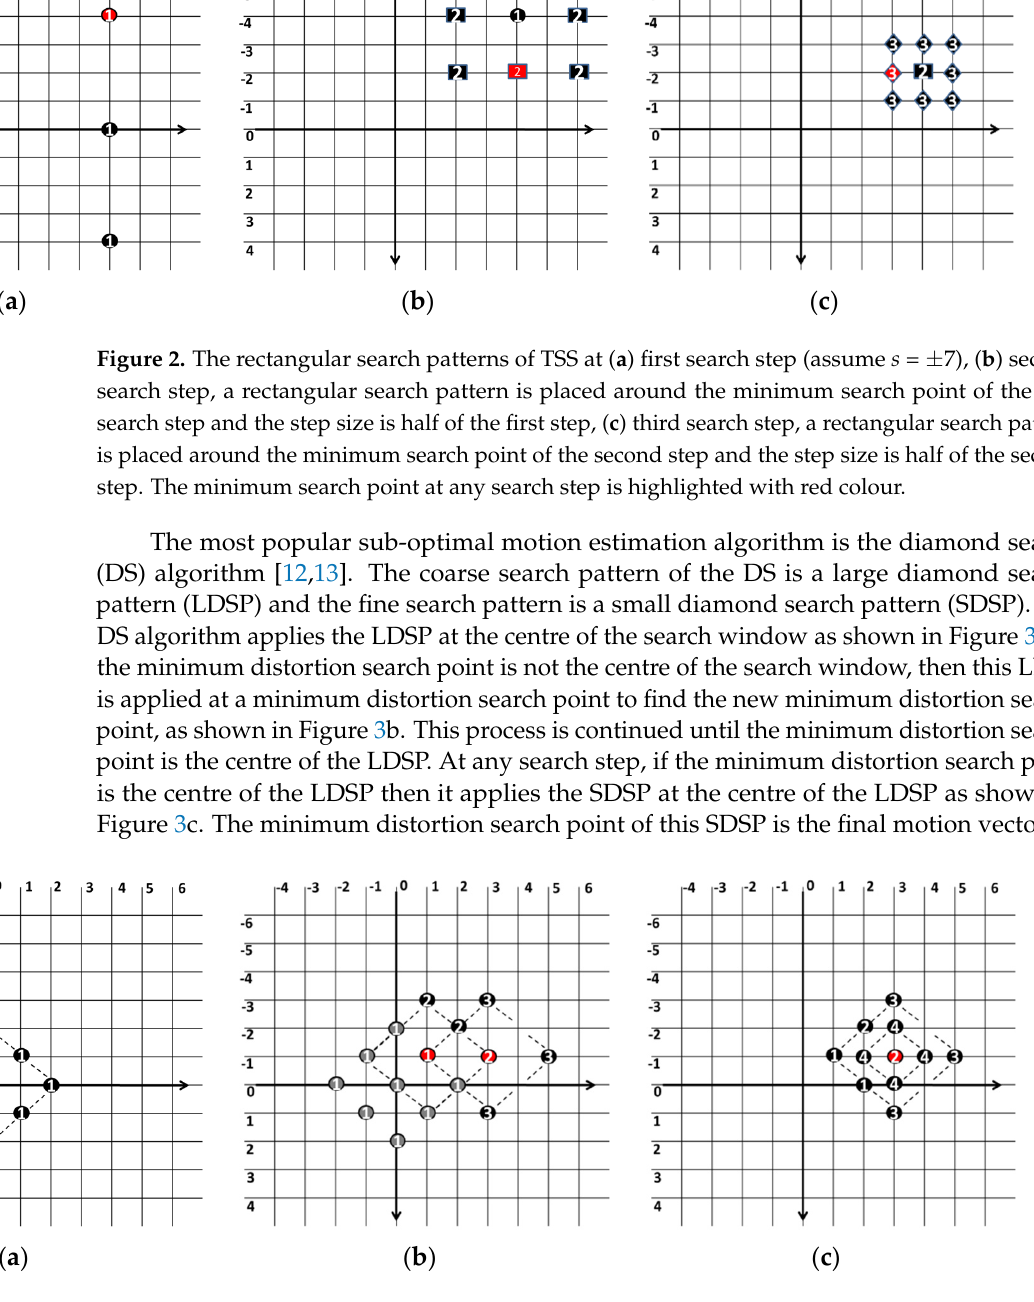
( b ) Figure 4. Motion vector searching procedure with an example, ( a ) using NTSS at (2, − 2), ( b ) using HS (3, − 2). Each search point is identified by a step number and a point with red colour indicates the minimum search point. The LDSP shape is not closer to the circle and so, the results obtained by the HS are more accurate than those of the DS. Figure 4b shows an example of searching for the mo- tion vector by the HS algorithm. The cross-diamond search (CDS) algorithm [16] shows better performance when compared to DS. At first, it employs a cross shaped pattern (CSP) before applying the search patterns of the DS. A small amount of a motion vector related block within 5 × 5 search window is found by the CSP. This algorithm also uses a halfway-stop technique in order to locate the blocks that have a small amount of motion. The cross-diamond-hexagonal search (CDHS) [17] shows better performance when com- pared to the HS. At first, it employs a cross shaped pattern before applying the search patterns of the HS. A small amount of motion vector related blocks within 5 × 5 search window are found by the cross shaped pattern. This algorithm also uses a halfway-stop technique in order to locate the blocks that have a small amount of motion. A star-dia- mond (SD) search pattern is proposed in [23]. This algorithm applies a star shaped search pattern with nine search points for coarse search and applies a small diamond pattern for fine search. It provides better performance than the diamond search algorithm. In [24], the authors have proposed a diamond–hexagon search algorithm which provides the benefits of both diamond and hexagonal search patterns for better results. The authors of [25] have proposed a prediction-biased motion estimation algorithm by employing the diamond search pattern. This algorithm provides reduced computational cost with good image quality. In [26], an enhanced adaptive threshold motion estimation algorithm is described,